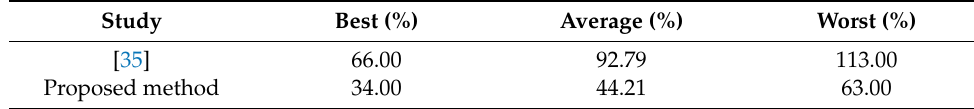
Table 6. Unauthorized PV capacity estimation result by